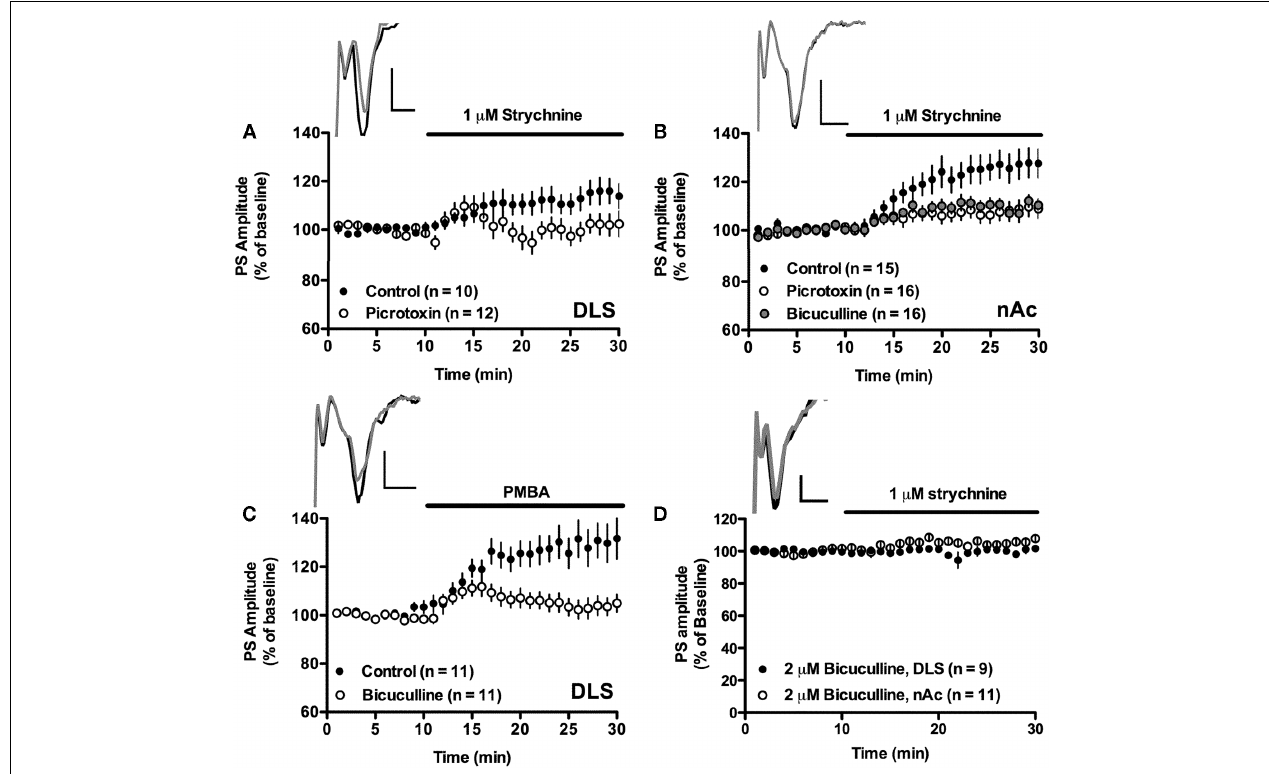
prevented in slices treated with bicuculline (20 μ M). Example traces show evoked population spikes at baseline (black) and after 15–20min of PMBA-treatment (gray). (D) Slices treated with a lower concentration of bicuculline (2 μ M) also inhibited strychnine-induced enhancement of PS amplitudes. Example traces show evoked population spikes in the nAc at baseline (black) and after 15–20min of strychnine perfusion in a bicuculline-treated slice (gray). Data show mean PS amplitudes compared to baseline with SEM. Calibration: 0.2mV,